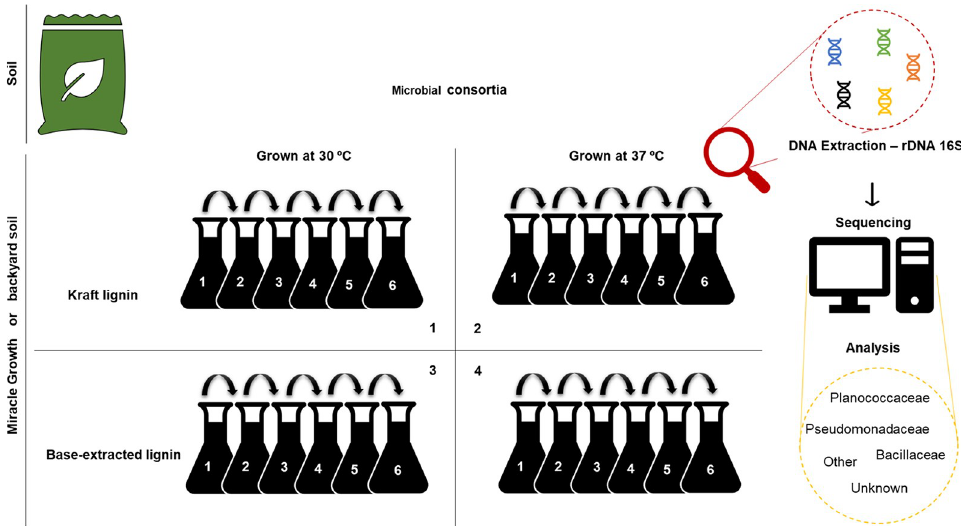
Fig 1. Schematic of enrichment experiment strategy. Eight microbial consortia enriched for microorganisms able to utilize lignin (i.e., base-extracted or Kraft) as carbon source. Four of the consortia had back yard soil and other four had MG soil as the as the original source of microorganisms. The enrichment experiments were conducted in aerobic conditions at 30˚C and 37˚C. Every two weeks, an aliquot of the growth medium containing microorganisms was transferred to fresh culture medium. The consortia were enriched over six cycles (passages), totaling 12-weeks. Samples were taken for each passage, DNA was extracted and the ribosomal gene 16S rDNA was amplified and sequenced.